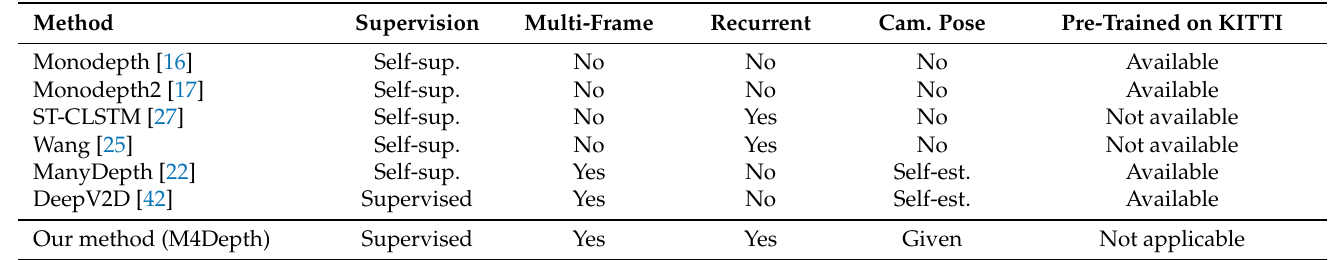
Table 1. Main characteristics of a selection of depth estimation methods used for comparison in this